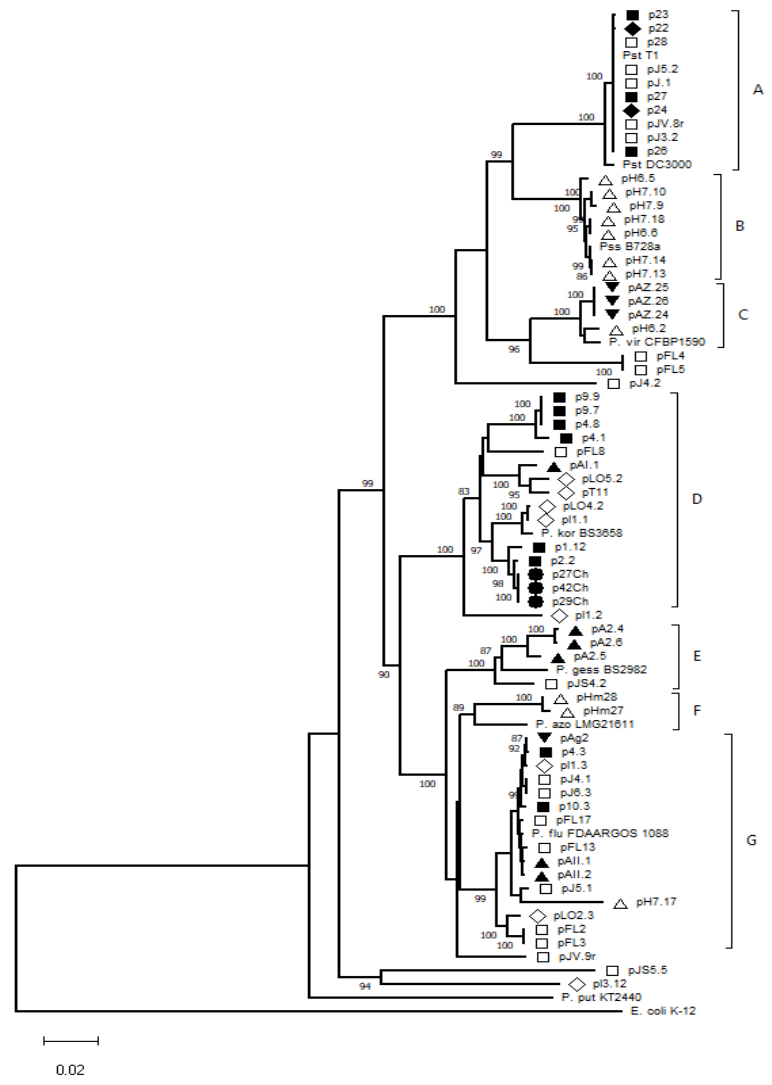
Figure 2. Neighbor-joining tree of the MLSA dataset. The total length of the compared sequences is 3095 bp in the final dataset. The seven major groups discussed in the text are labeled (A–G). Bootstrap scores greater than 80 are given at each node. E. coli K-12 (genome accession number U00096) strain was used as outgroup. The evolutionary distances were computed by using the Tamura–Nei method and are in the units of the number of base substitutions per site. The rate variation among sites was modeled with a gamma distribution (shape parameter = 2). The location of the isolates is represented with different markers next to each strain name as follow: empty square, Limache (Valpara í so); filled square, Hijuelas (Valpara í so); empty diamond, Chimbarongo (O ´ Higgins); filled diamond, Quillota (Valpara í so); empty triangle, Quill ó n (B í o B í o); filled triangle, Olmu é (Valpara í so); filled inverted triangle, Teno (Maule); filled circle, Chill á n (B í o B í o). Representative sequences from the genus Pseudomonas included as references are listed below, along with their geographic origins in parenthesis and accession numbers in square brackets: P. azotoformans LMG21611 (Japan) [LT629702], P. fluorescens FDAARGOS 1088 (Germany) [NZ_CP068151.1], P. gessardii BS2982